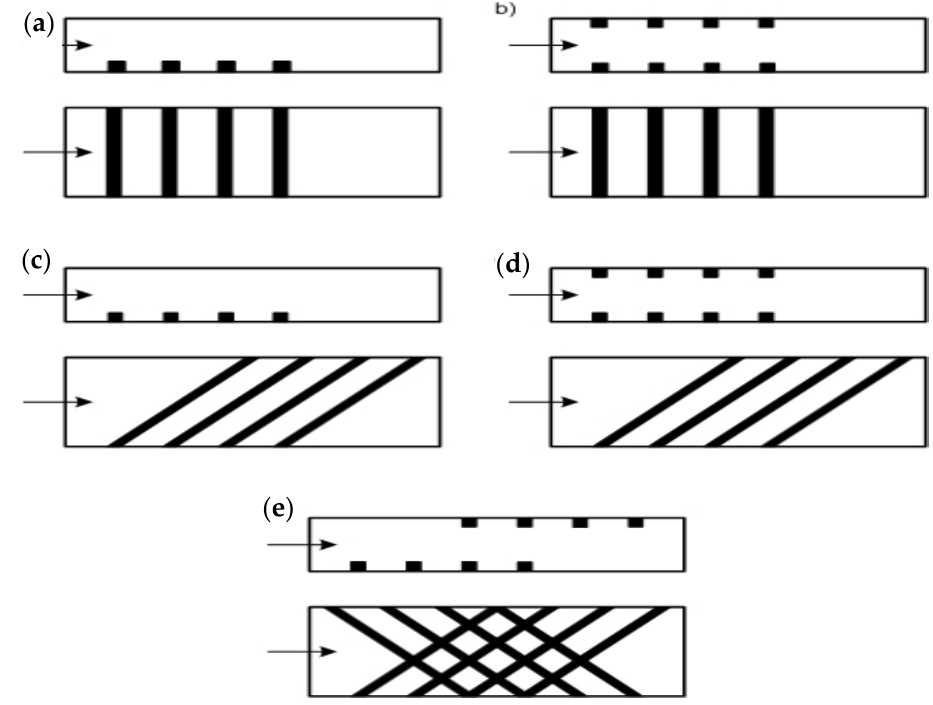
Figure 4. Diagram of ribbed sections: ( a ) configurations_1 and _6, ( b ) configurations_2 and _7, ( c )